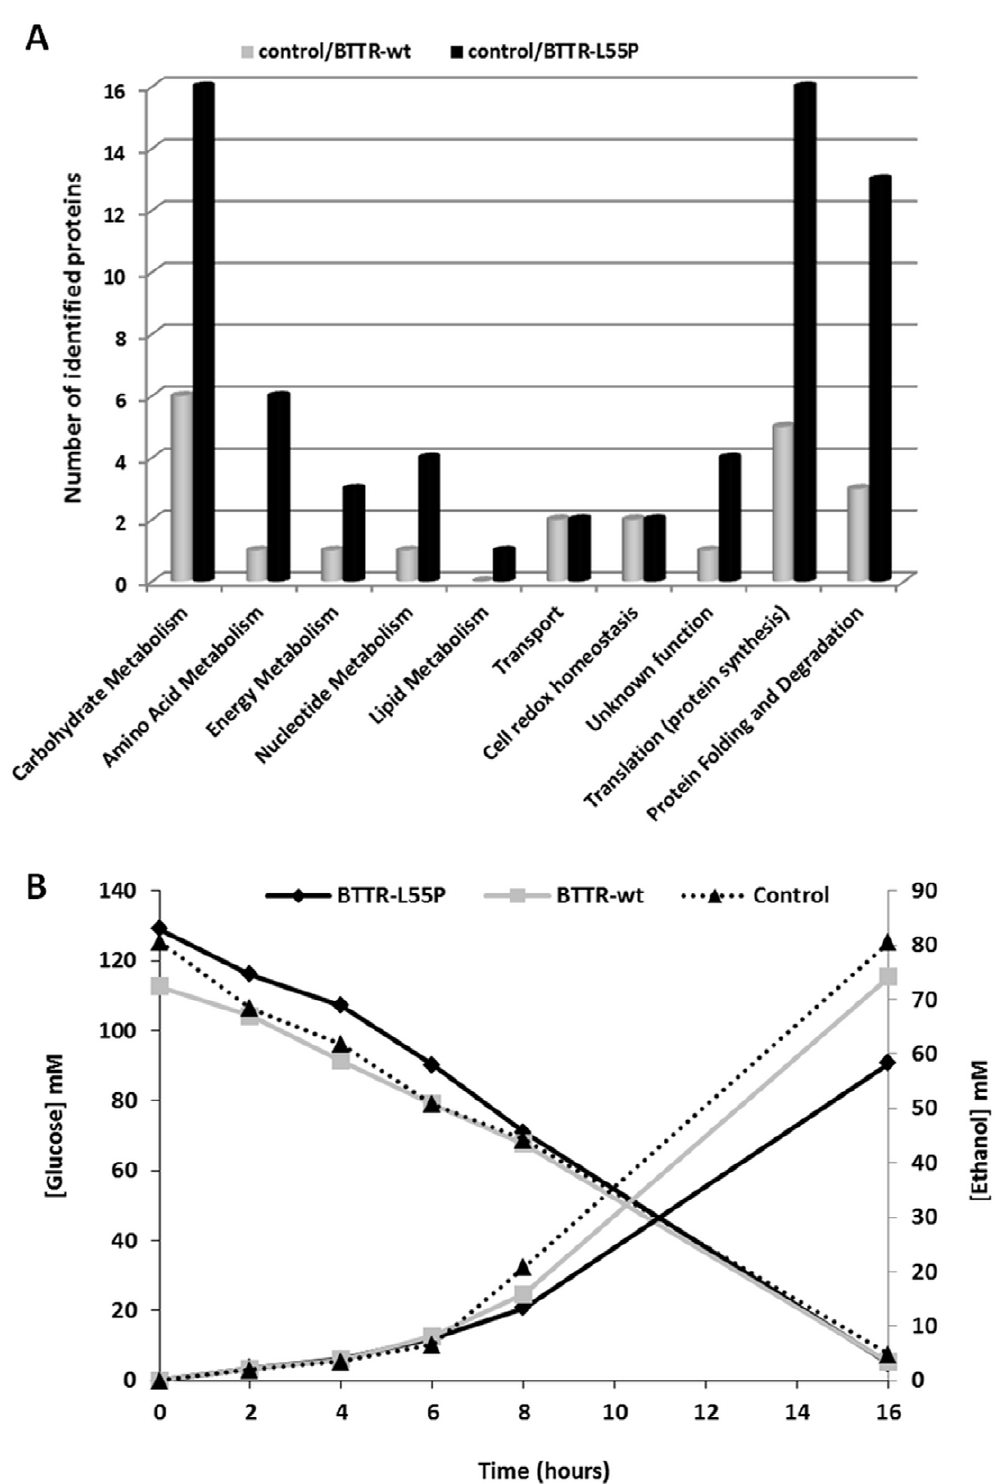
Figure 4. Expression profile in BTTR-wt and BTTR-L55P versus the control. (A) Number of the identified proteins according to the biological function, differentially expressed between the control and BTTR-wt (grey) and between the control and BTTR-L55P (black). Upon the expression of the amyloidogenic TTR variant L55P, a substantial increase in the number of differentially expressed proteins namely in proteins involved in cell metabolism, translation and protein folding and degradation is clearly detected. (B) D-Glucose consumption and ethanol production during cell growth in the control (dotted line), BTTR-wt (grey) and BTTR-L55P (black). A representative analysis is shown.